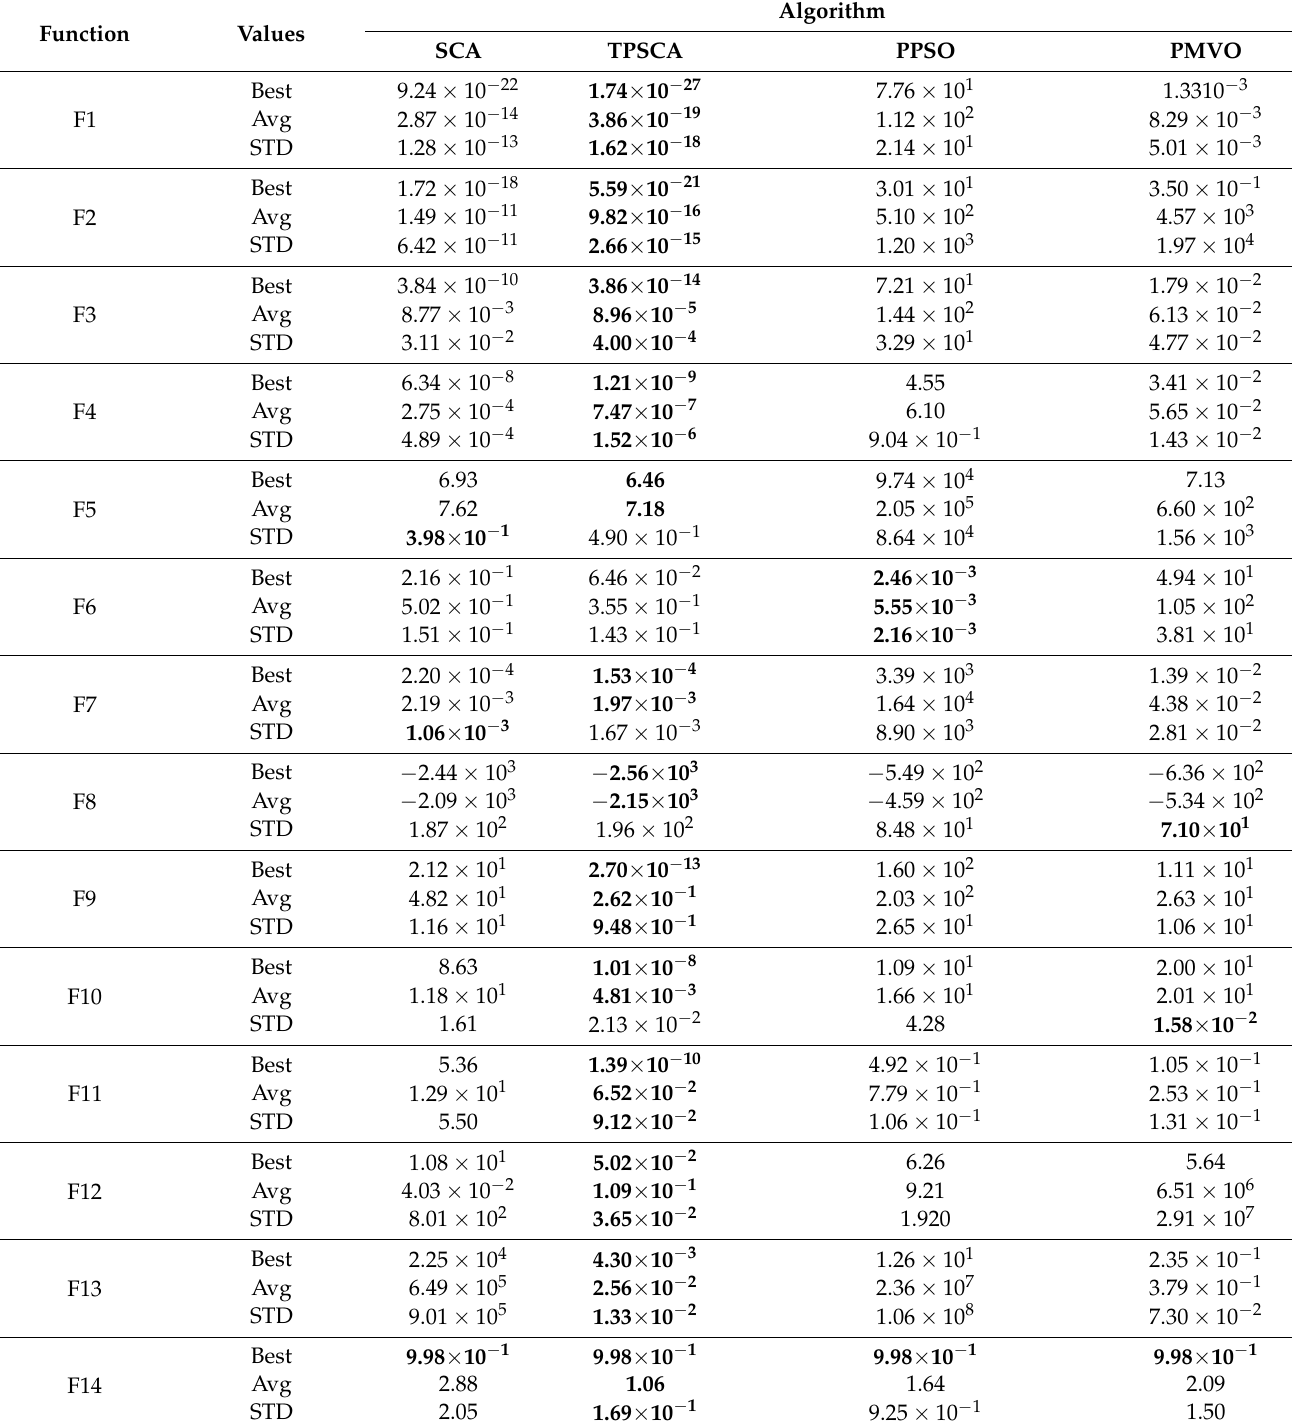
Table 7. The results of benchmark by SCA, TPSCA, PPSO and